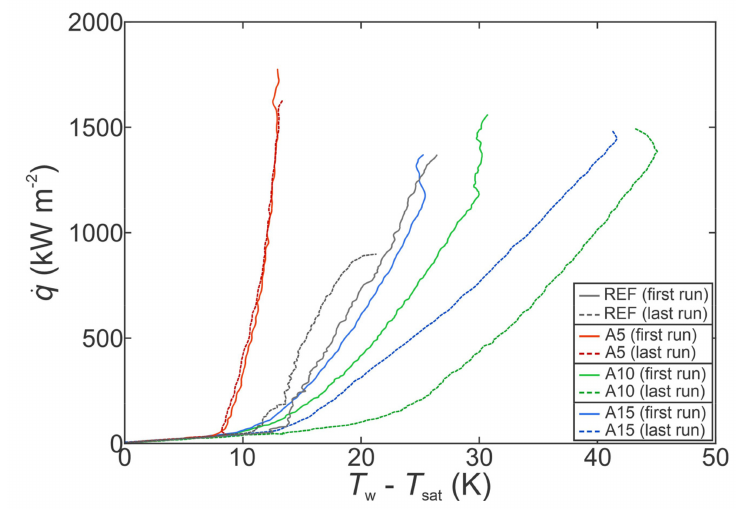
Figure 5. First and last boiling curve recorded on each